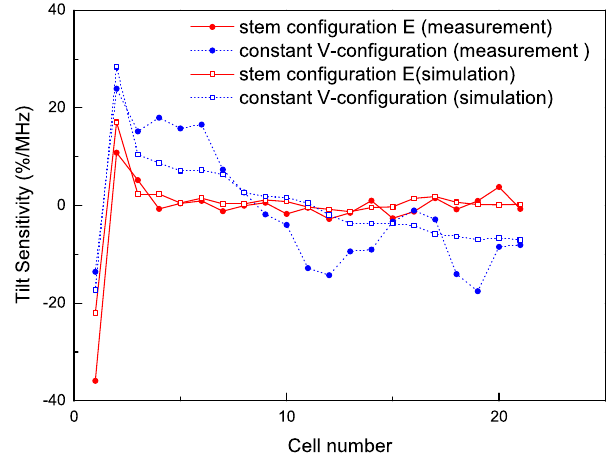
FIG. 22. Measured (dots) and simulated (circles) field tilt sensitivities of the 21 gaps model cavity for two different stem configurations: constant V-configuration (blue) and E configuration